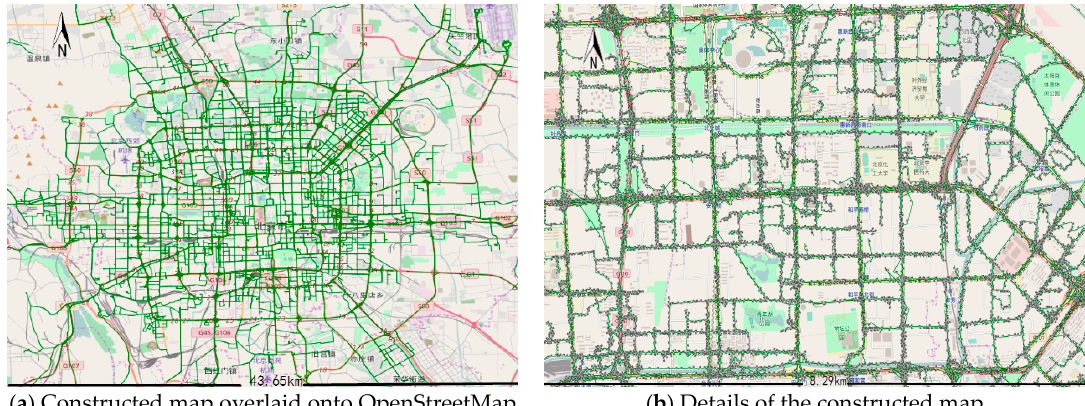
Figure 7. A detailed look at the processed trajectories. ( a ) A subarea of the base map from OSM, and ( b ) a snapshot of the processed trajectory. As shown in ( b ), there are many messy lines around road intersections, which require further processing to extract the real roads.